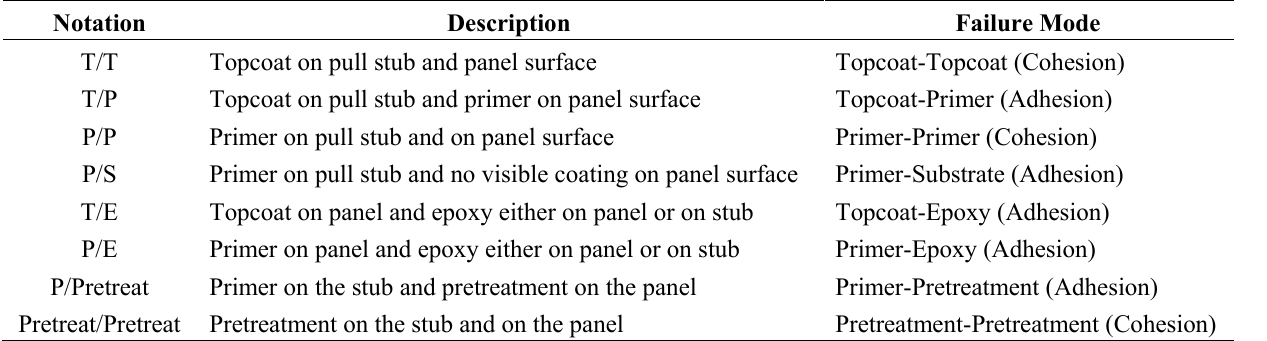
Table 7. PATTI coating failure